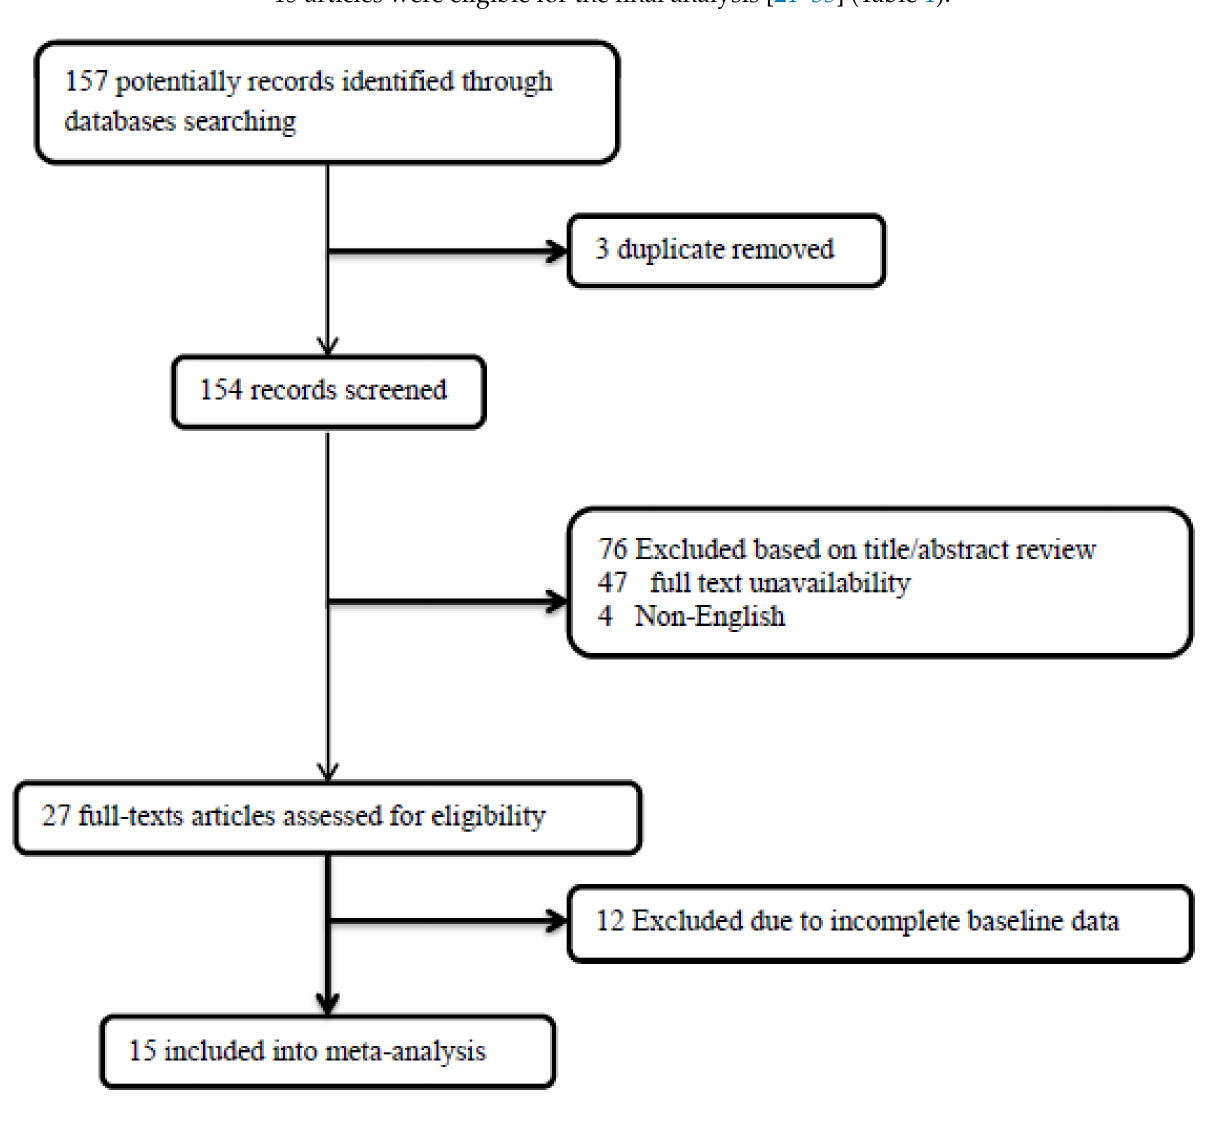
Figure 1. The flowchart of screening the eligible studies. Table 1. Original data extracted from included